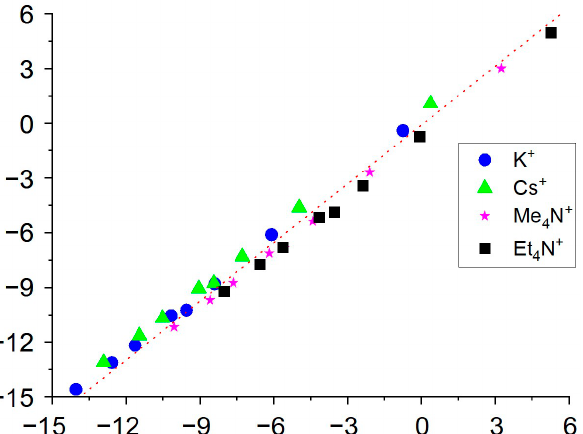
Figure 2. Correlation between coextraction constants calculated from [28] (Y-axis) and obtained in this paper (X-axis). Anions from left to right are as follows: Cl − , Br − , NO 3 − , I − , SCN − , ClO 4 − , Pic − , TPB − . The equation of the correlation line is y = 1.07x − 0.10.